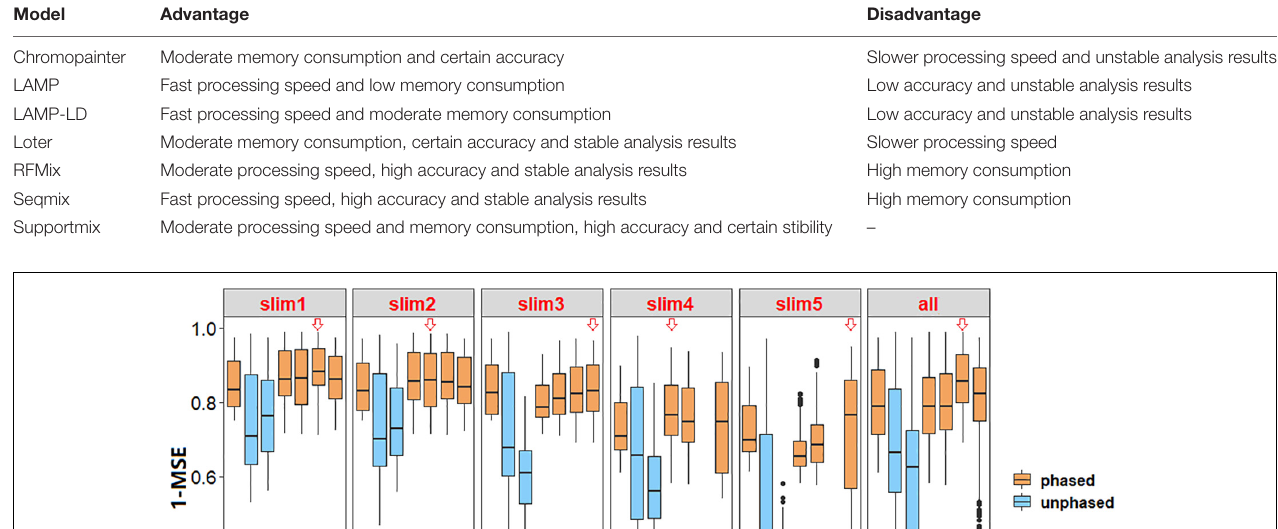
PCADMIX in the hybrid genome. The results of the analysis were consistent with those estimated in ADMIXTURE at K =